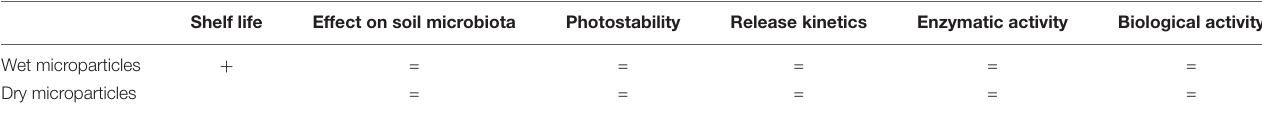
TABLE 2 | Comparison of the main results of the tests performed with wet and dry microparticles. The (=) symbol demonstrates that there is no difference in results between the microparticles and the ( + ) symbol demonstrates that one of the microparticles was better than the other. Shelf